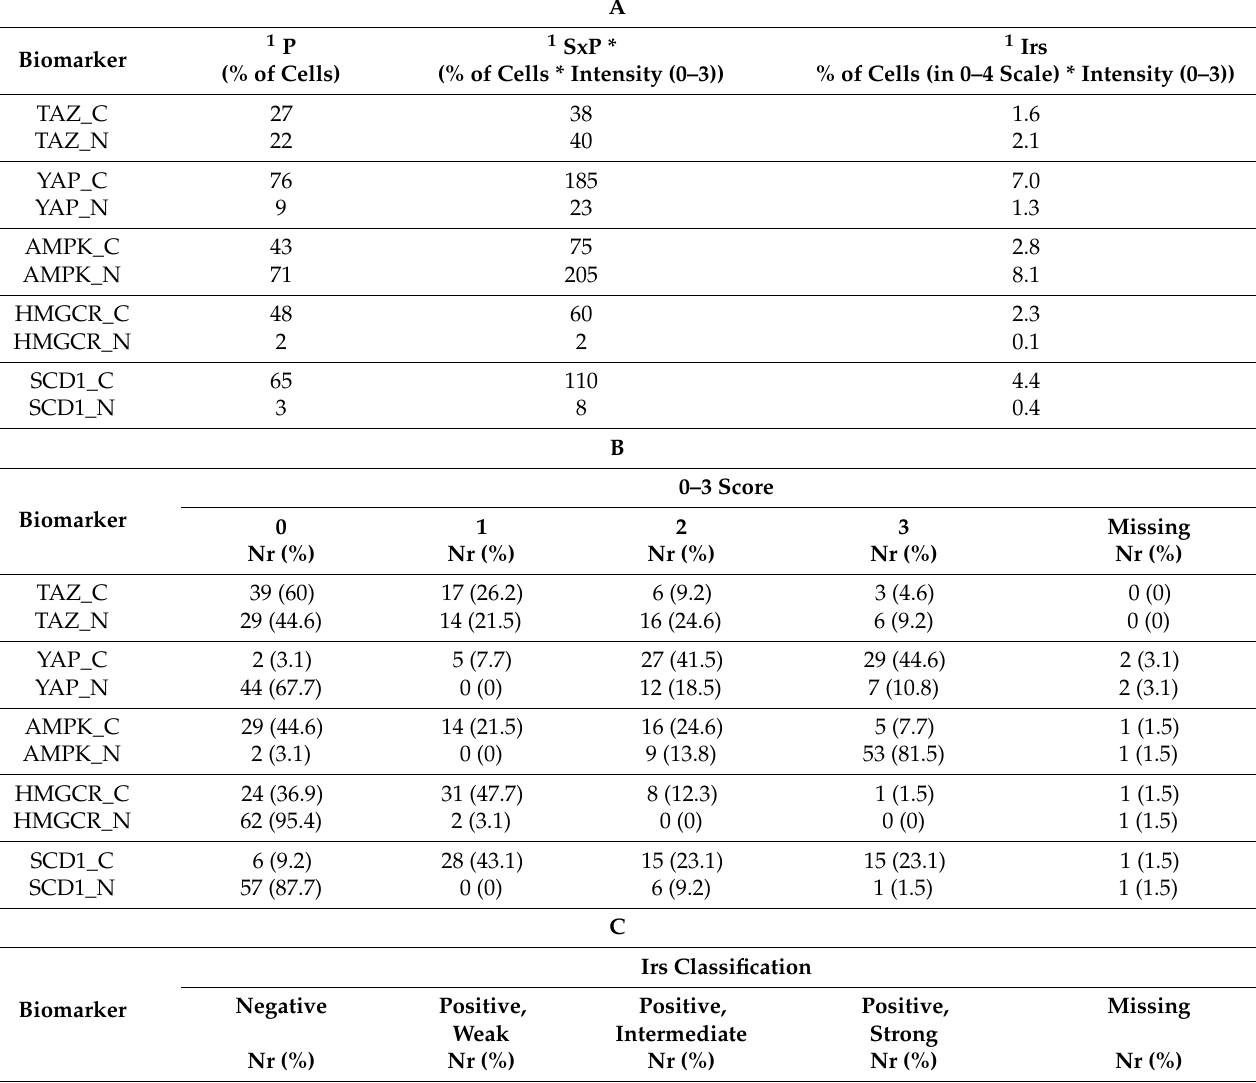
Table 2. Cytoplasmic and nuclear expression of TAZ, YAP, AMPK, HMGCR, and SCD1 (N = 65), according to ( A ) mean percentage of cells stained, ( B ) intensity of staining on a 0-3 scale, and ( C ) immunoreactive score